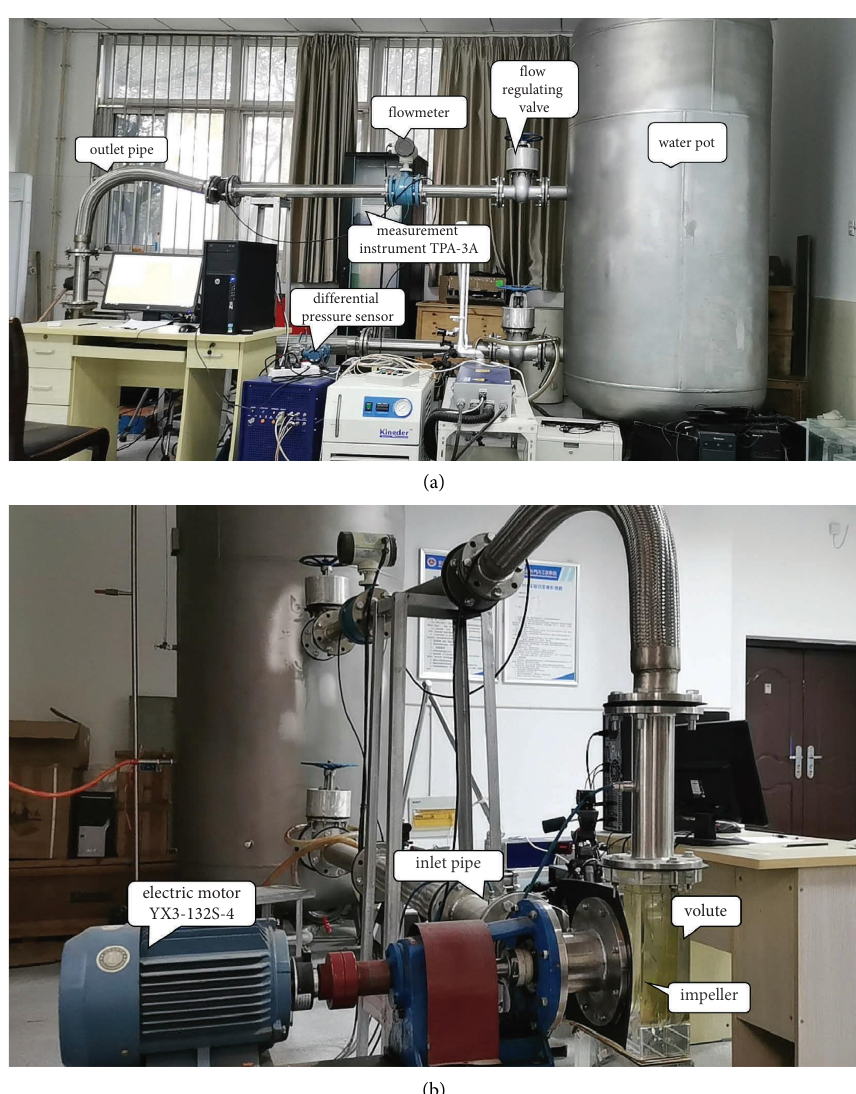
Figure 15: Closed pump performance test bench diagram: (a) front view and (b) lateral